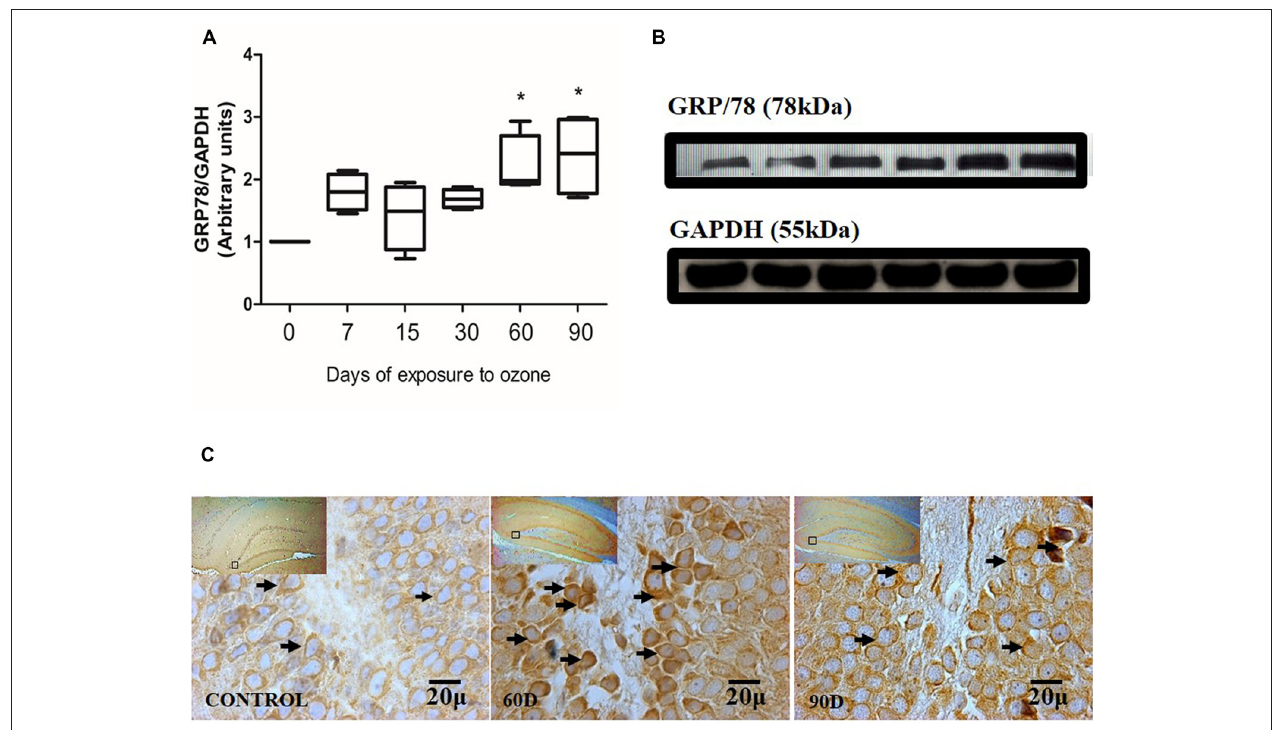
FIGURE 2 | Effect of chronic exposure to ozone on 78-kDa glucose-regulated protein (GRP78) expression in rat hippocampus. (A) Shows the densitometry analysis of the protein levels for GRP78 from rat hippocampus following exposure to ozone for 7, 15, 30, 60 and 90 days. There is a significant increase at 60 and 90 days of treatment. (B) The results show an increase in the protein expression following 60 and 90-day exposure to ozone ( ∗ p < 0.05) compared with the control groups. GAPDH staining was used as an internal control. (C) Effects of ozone treatments on GRP78 immunoreactivity in the dentate gyrus of rat hippocampus. Light photomicrographs show immunoreactivity in GRP78 of cells from hippocampus of rats exposed to ozone. The control group showed low immunoreactivity. We observed an increase of immunoreactivity for GRP78 at 60 and 90 days of exposure to ozone. Arrows show GRP78 immunoreactivity 100 × . The square indicates the area that is shown as 100 ×